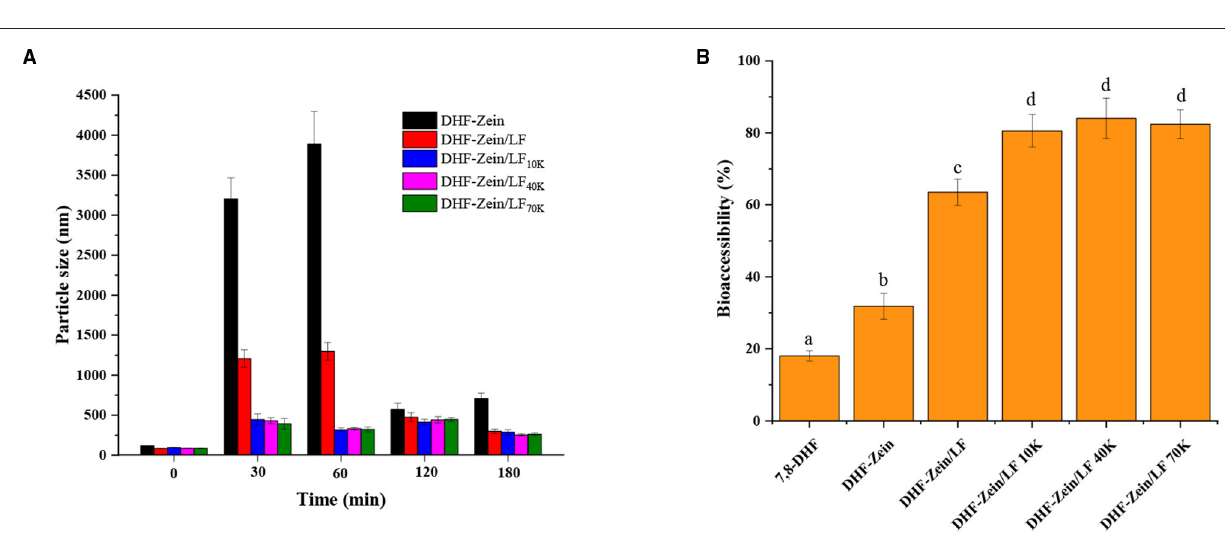
FIGURE 10 | Influence of in vitro digestion time on the particle size of DHF-zein, DHF-zein/LF, DHF-zein/LF 10K, DHF-zein/LF 40K, and DHF-zein/LF 70K (A) . In vitro bioaccessibility (B)